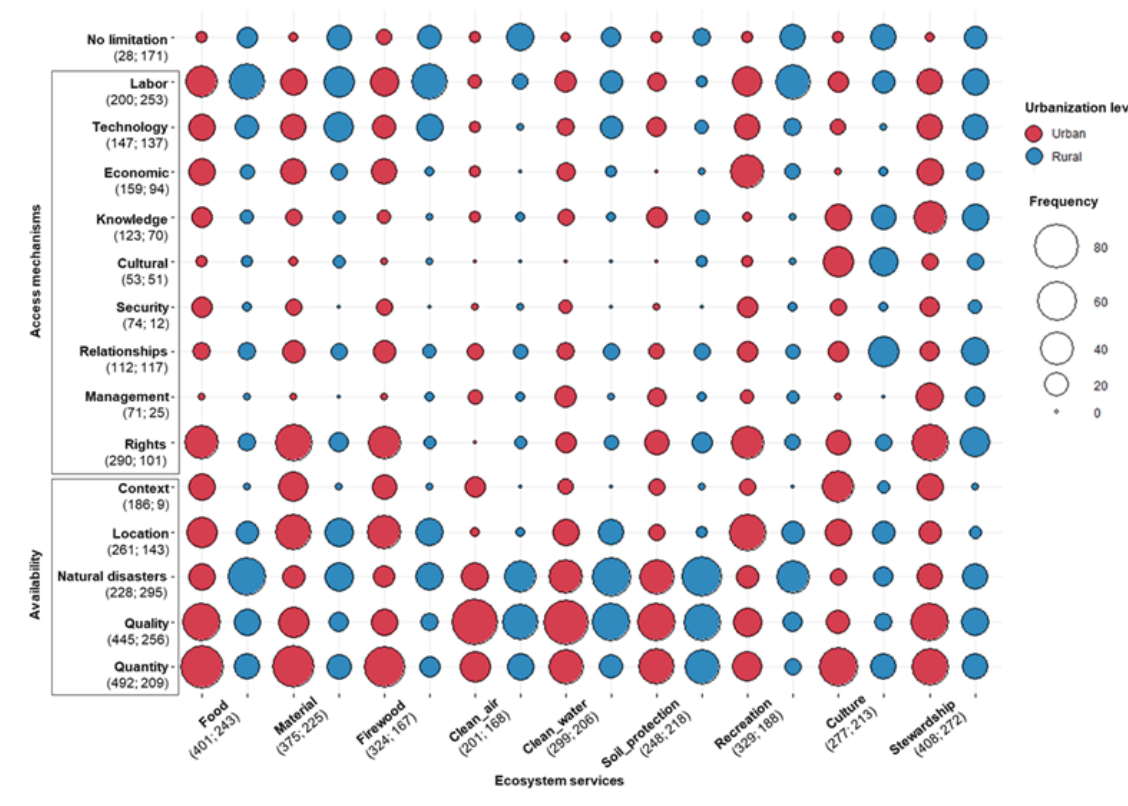
Fig. 2 . Frequency of urban and rural dwellers identifying a limitation for each ecosystem service. The total number of mentions of a limitation, and of limitations per ecosystem service are indicated in parentheses for urban and rural, respectively.